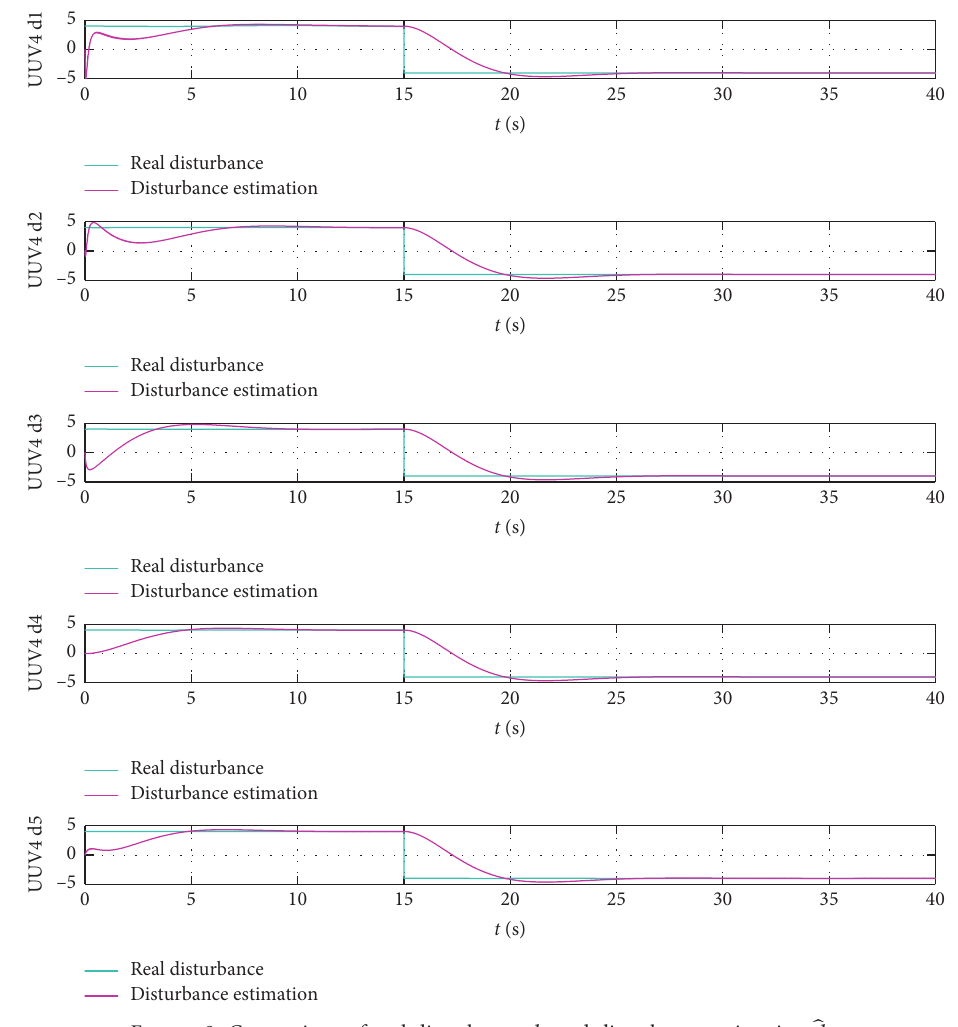
and disturbance estimation 􏽢 d 4